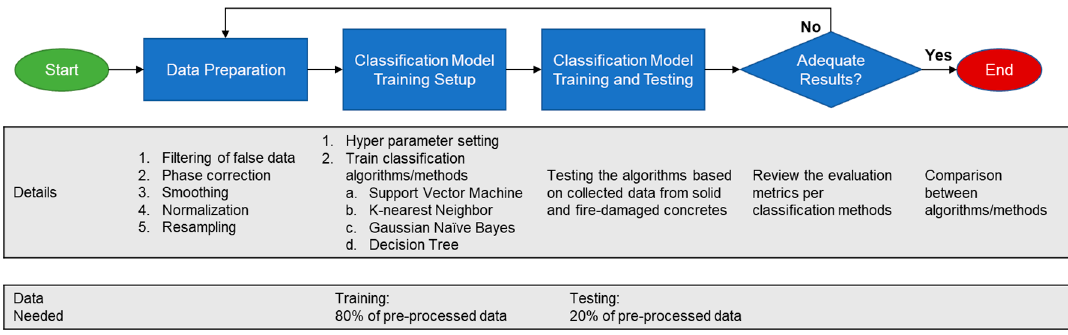
Figure 6. General flowchart for the machine learning method used in this study.